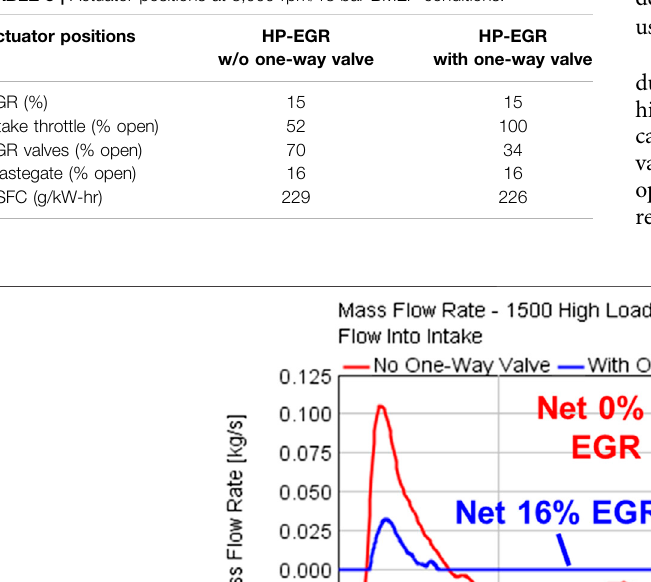
TABLE 5 | Actuator positions at 3,000 rpm/13 bar BMEP conditions.